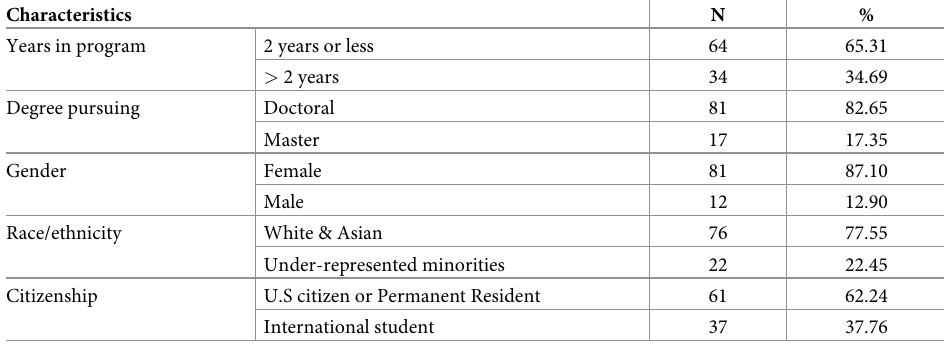
Table 1. Demographic information of participants (N =